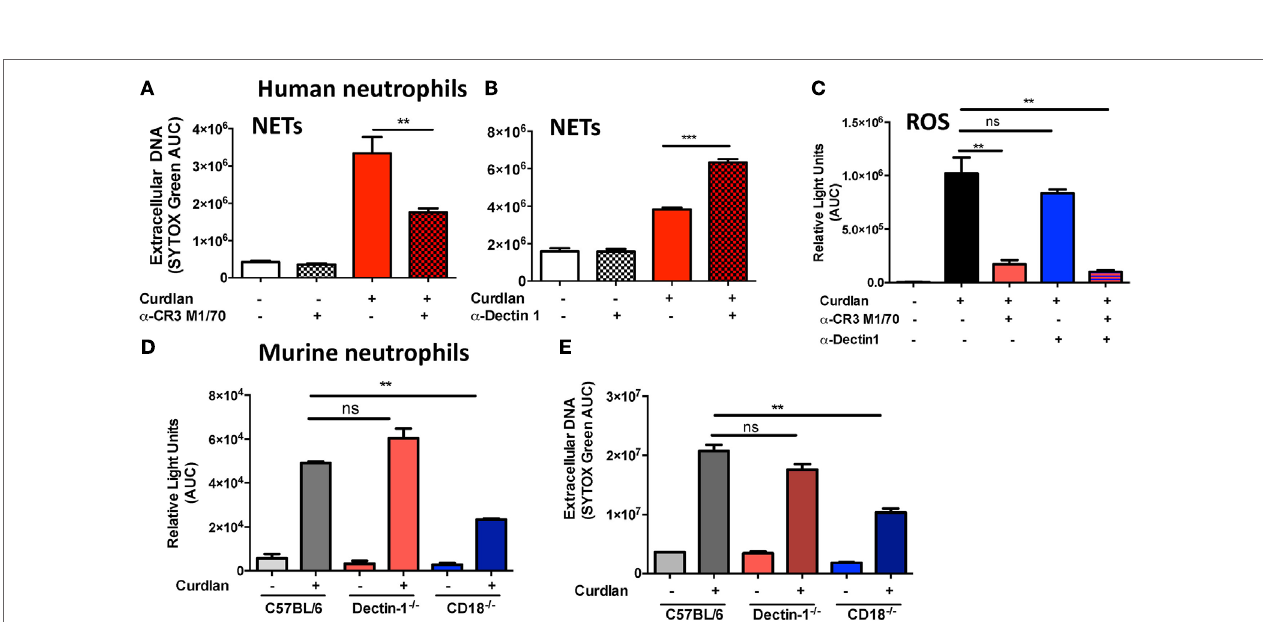
FigUre 3 | Distinct roles for CR3 and Dectin-1 in β -glucan-induced reactive oxygen species (ROS) production and neutrophil extracellular trap (NET) formation. (a–c) Human neutrophils; (D,e) murine neutrophils. Neutrophils were incubated with β -glucan (curdlan) in the presence of the anti-CR3 blocking antibody M1/70 (30 μ g/ml) (a) or with the anti-Dectin-1 blocking antibody 22H8 (Invivogen, 20 μ g/ml) (B) . (a,B) DNA release was quantified by SYTOX Green and expressed as area under the curve. (c) ROS production measured by luminol. (D,e) DNA release and ROS production by mouse bone marrow neutrophils from C57BL/6, Dectin-1 − / − , and CD18 − / − mice stimulated with curdlan. p Values are biological replicates of at least three repeat experiments and were calculated using ANOVA with Tukey post hoc analysis (*** p < 0.001, ** p < 0.01, and * p < 0.05).